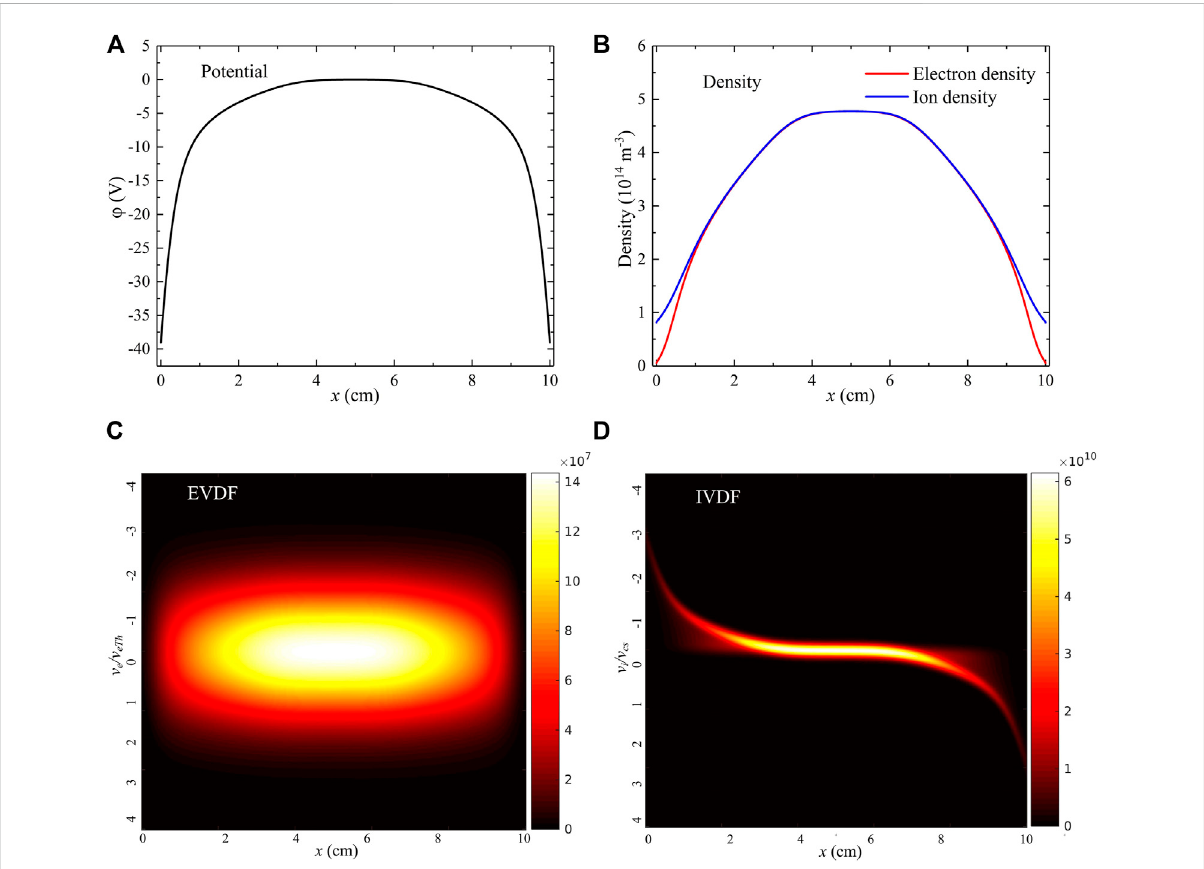
FIGURE 2 Typical simulation results obtained by the 1D1V kinetic simulation. (A) Space potential. (B) Electron and ion density. (C) Electron velocity distribution function. (D) Ion velocity distribution